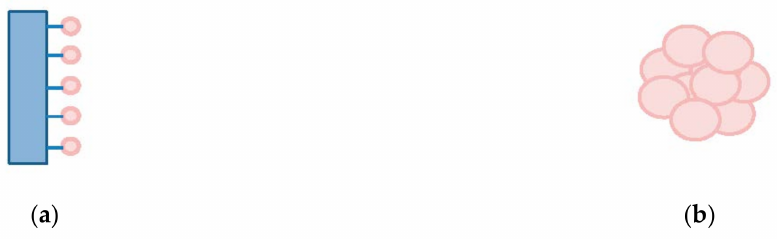
Figure 3. Enzymatic chemical immobilization techniques: covalent bonds ( a ) and cross-linking ( b